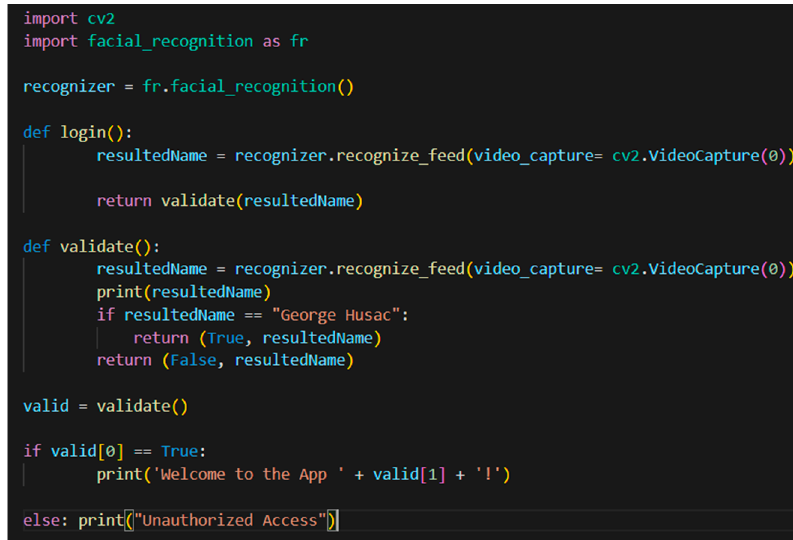
Figure 12. Login class.